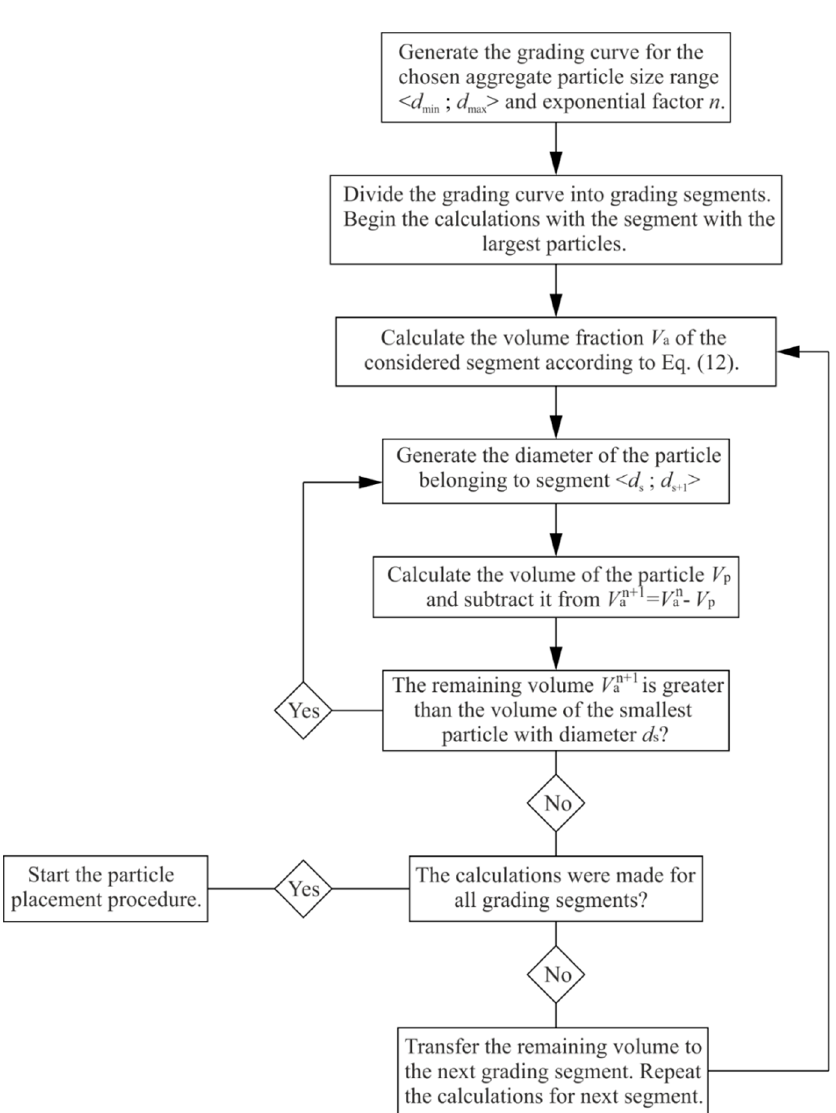
Figure 2. Generation of the aggregate particles.